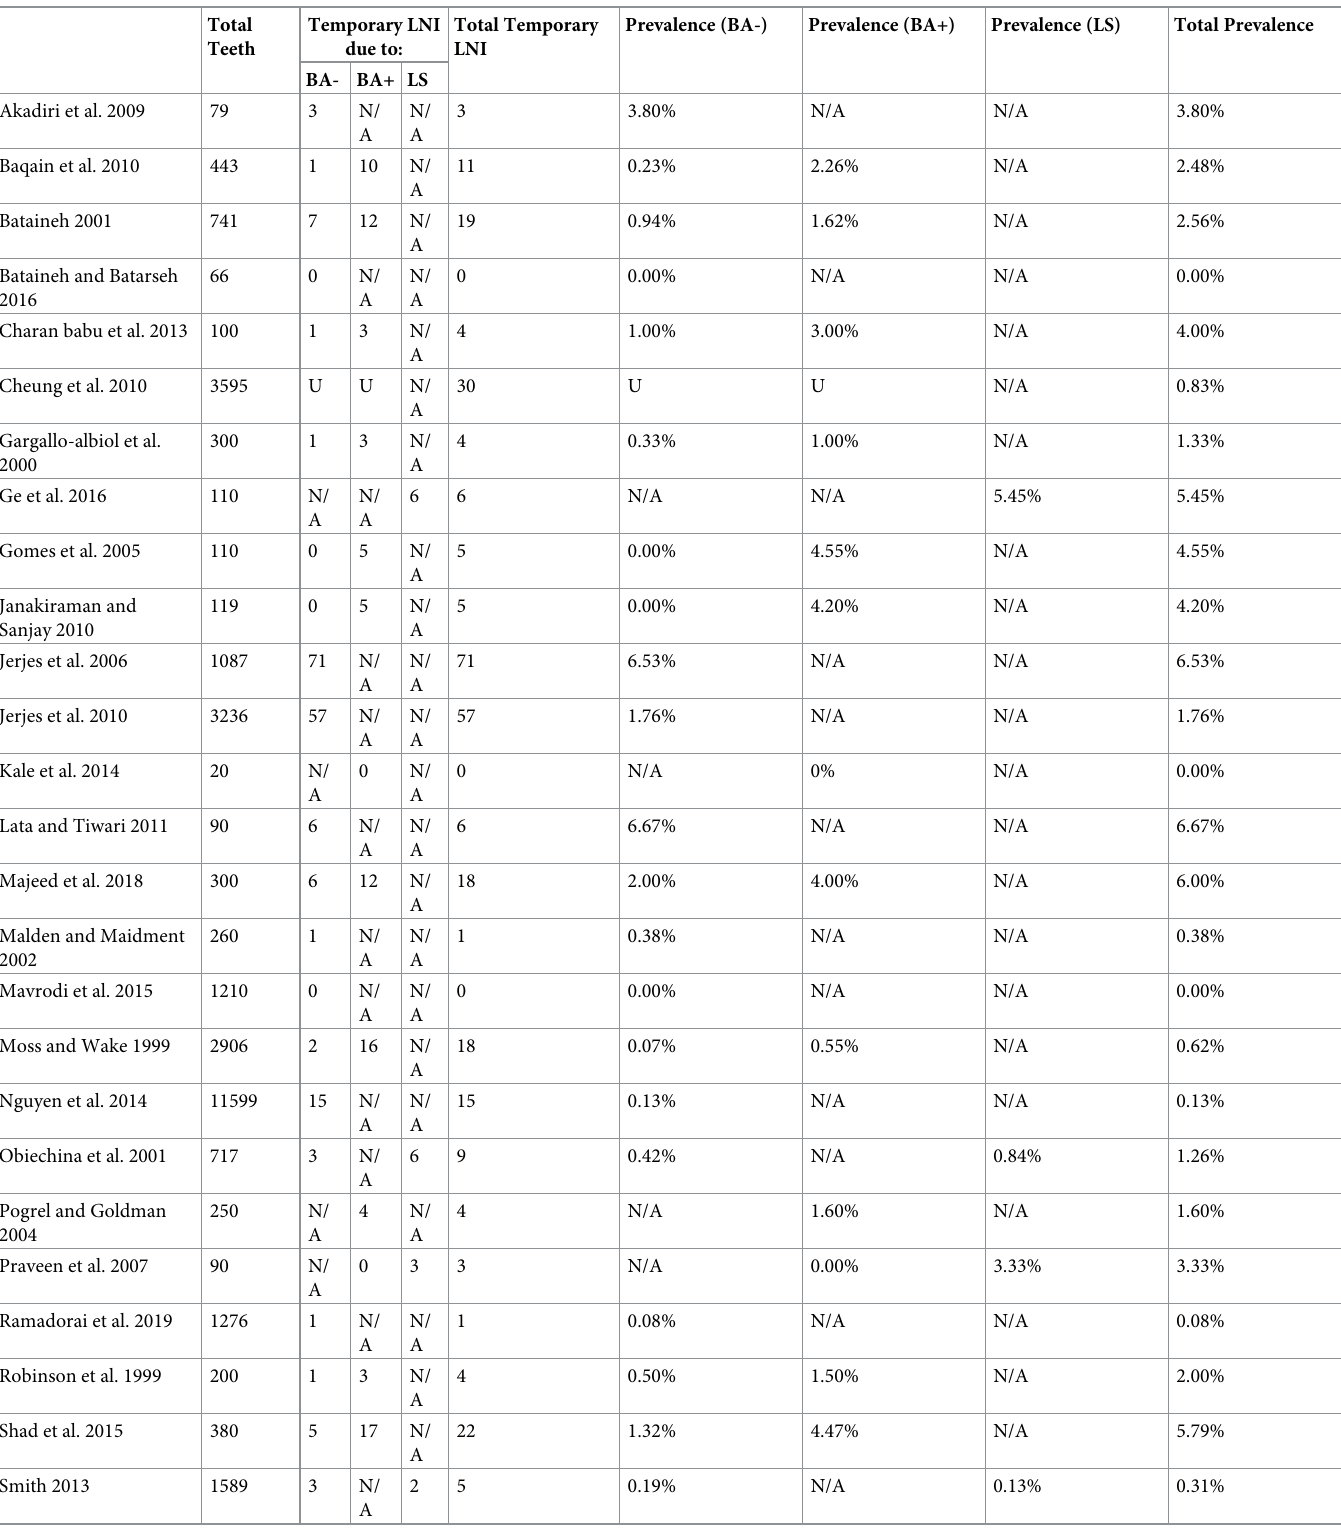
Table 3. Prevalence of temporary LNI using BA-, BA+ and